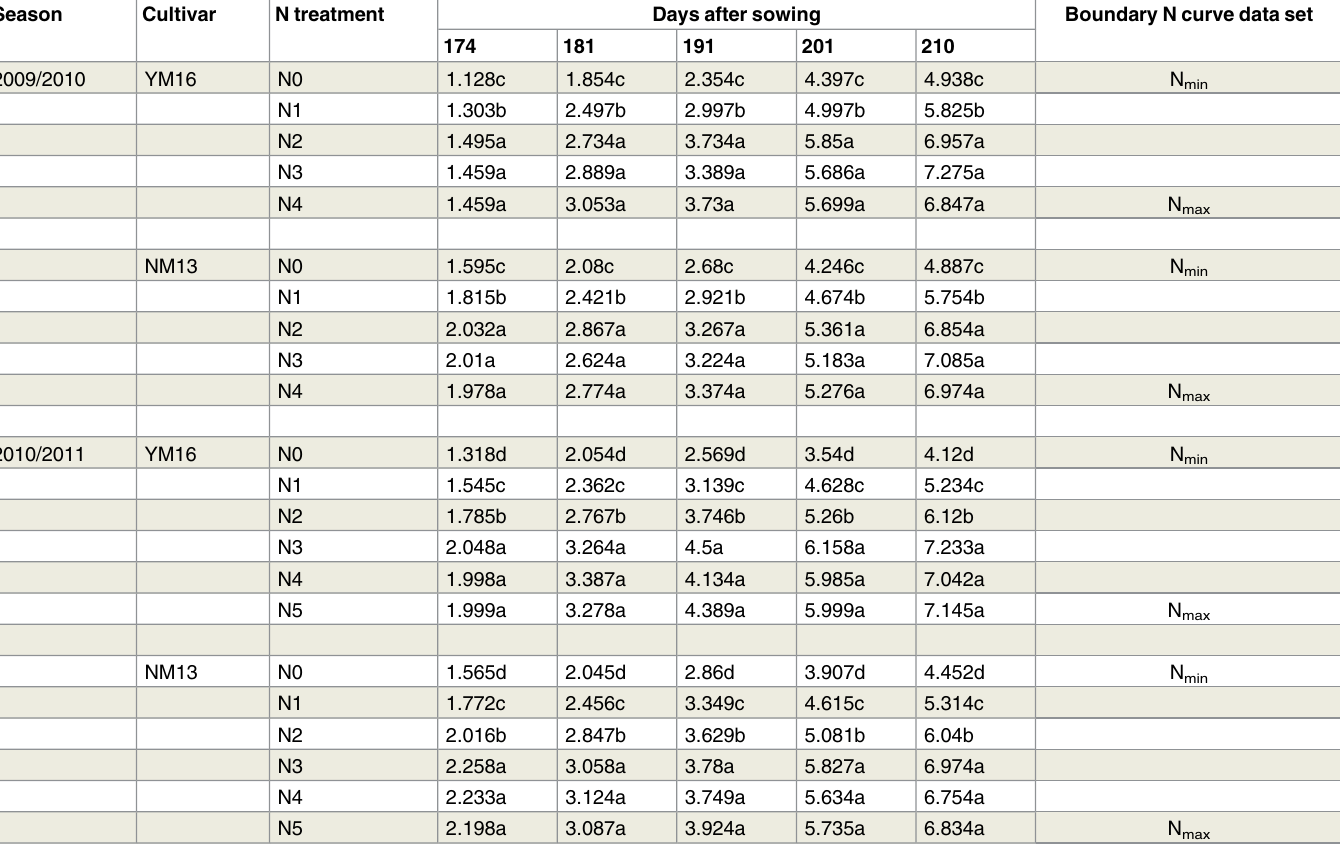
Table 2. Changes of spike dry matter (t ha -1 ) for winter wheat with time (days after sowing) under different N application rates in experiments con- ducted during 2009–2011 seasons. Season